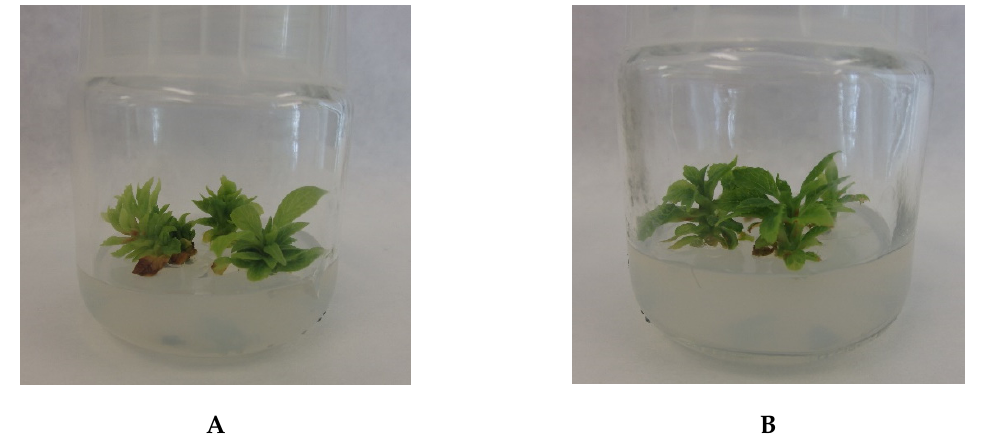
Figure 1. The morphological appearance of Schisandra rubriflora microshoots from agar in vitro cultures (MS medium with 1 mg/L 6-benzyladenine (BA) and 0.5 mg/L 1-naphthaleneacetic acid (NAA), after a 30 day growth period): ( A ) female (F) line; ( B ) male (M) line.